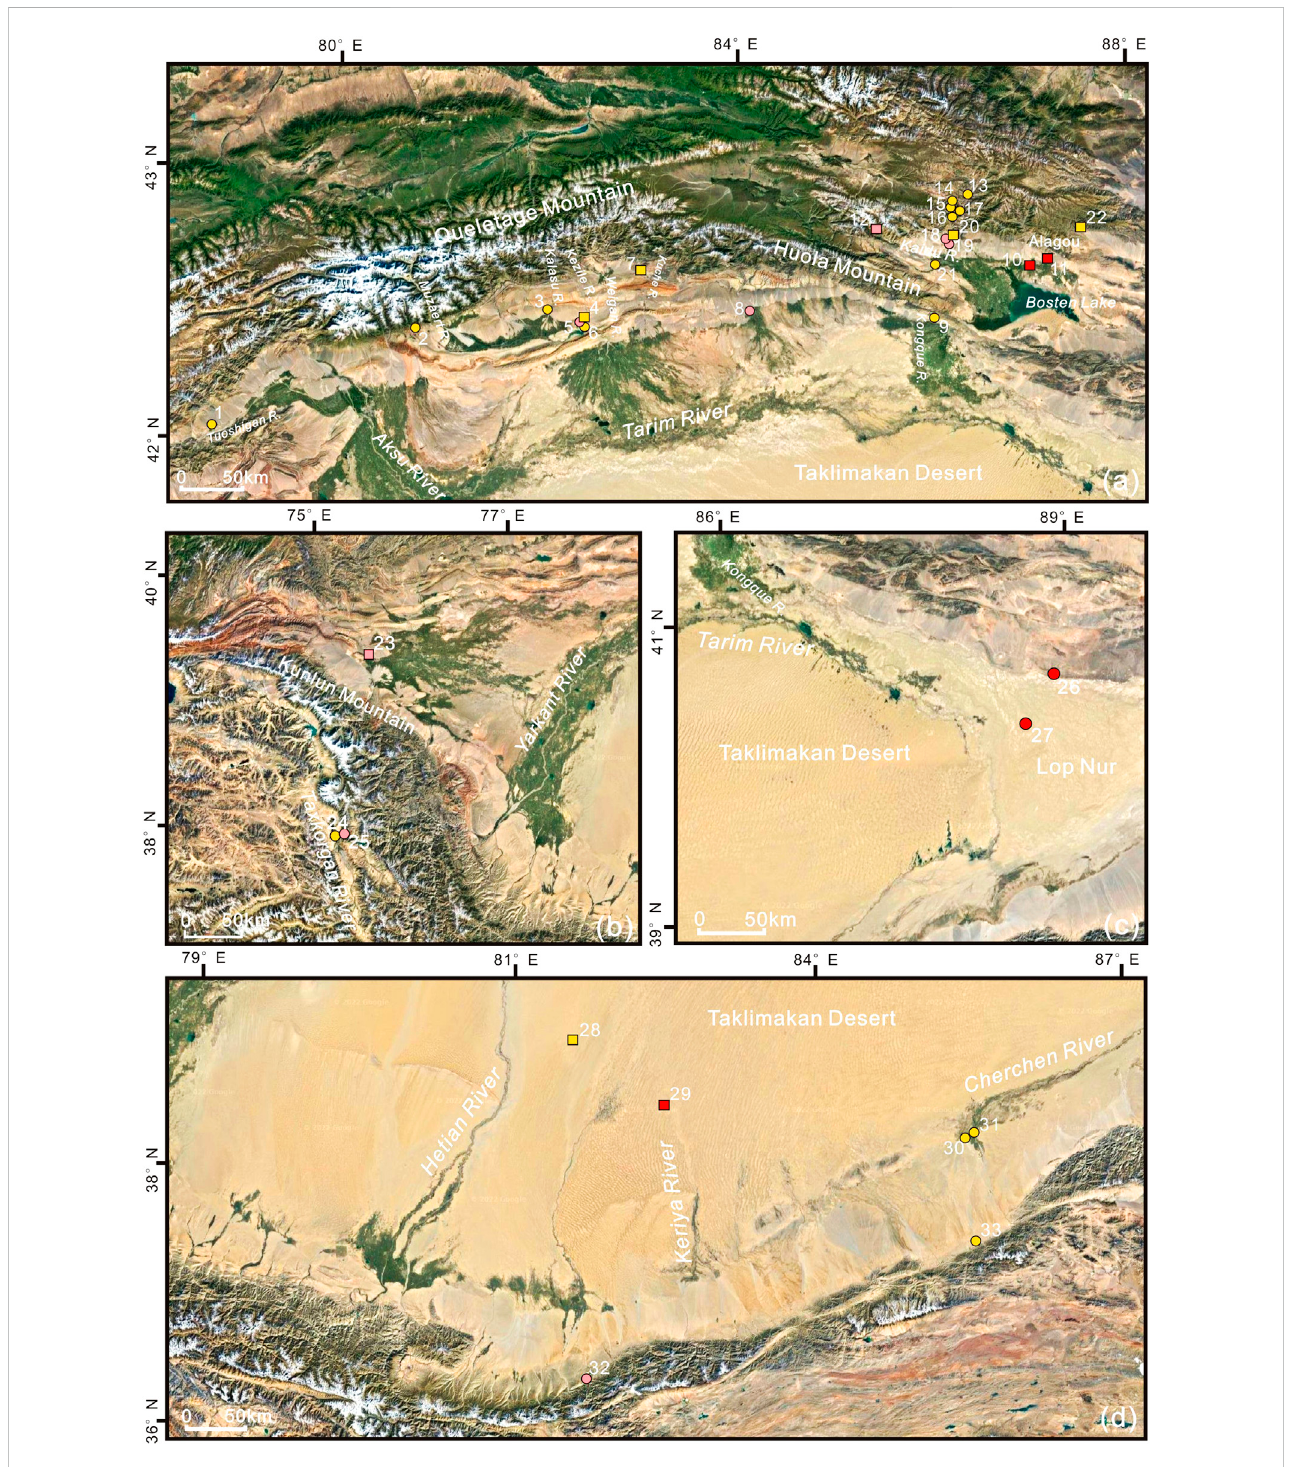
FIGURE 3 Topographic map of Tarim Basin and the sites mentioned in this study. (A) Northern margin area of Tarim Basin. 1. Kulansarike; 2. Baozidong M41; 3. Duogang;4.Kezier;5.Keziertuershuiku;6.Karigayi;7.Tikemaike;8.Qunbake;9.Shanghuxiang;10.Xintala;11.Quhui;12.Mohuchahan;13.HabuqihanIandII; 14.Narenhabuqihangou;15.DaxigouNo.1;16.Qiaoenqiakeledeke;17.DaxigouNo.4;18.ChawuhuNo.4;19.ChawuhuNo.1;20.Hejingzhonggongyeyuanqu; 21.Baileqier; 22.Hongshangou. (B) Southwestern margin area ofTarimBasin. 23. Wupaer; 24. Jierzankale; 25. Xiabandi. (C) Eastern margin areaof Tarim Basin. 26. Gumugou; 27. Xiaohe. (D) Southern margin area of Tarim Basin. 28. Yuansha Gucheng; 29. Northern Niya; 30. Zhagunluke; 31. Jiawaairike; 32. Liushui; 33.